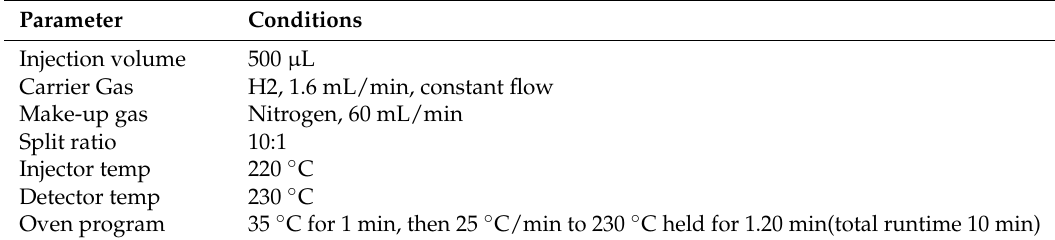
Table 1. Gas chromatograph operating